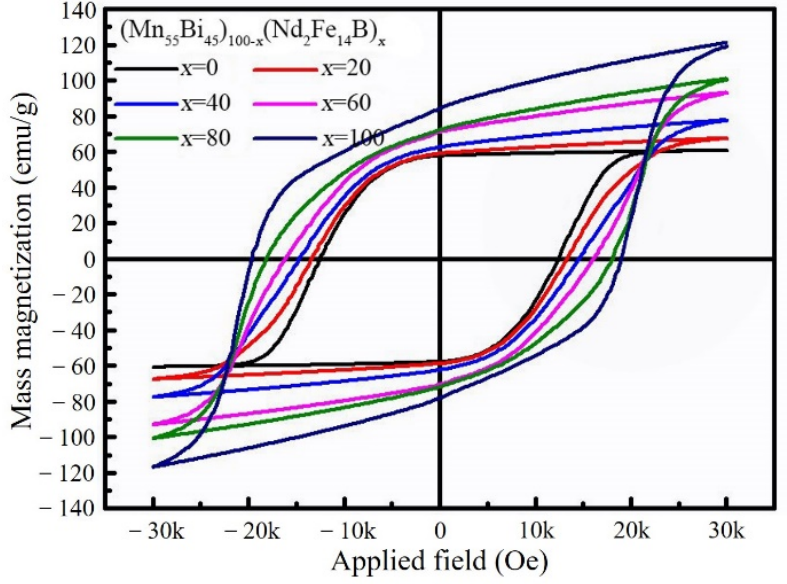
Figure 3. The room temperature hysteresis loops of the bulk (Mn 55 Bi 45 ) 100 − x /(Nd 2 Fe 14 B) x ( x = 0, 20, 40, 60, 80, and 100) hybrid magnetic alloys.